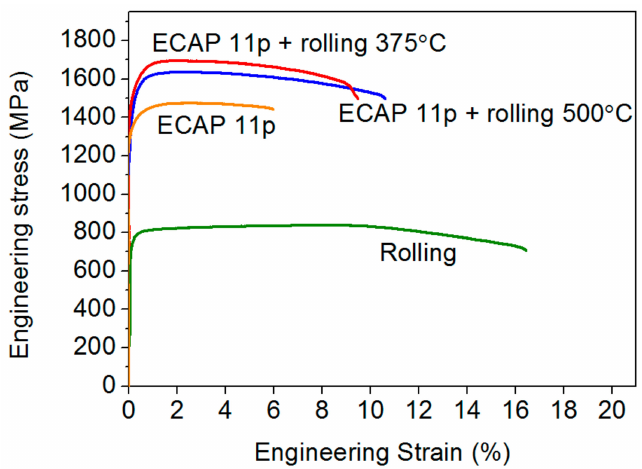
Figure 9. Engineering “stress–strain” curves for the TWIP steel processed by warm rolling, ECAP to 11 passes (denoted as ECAP 11p), and ECAP 11p + rolling at two temperatures. Note that the elongation to failure of the rolled and ECAP 11p + rolled samples cannot be directly compared to the elongation to failure of the ECAP 11p samples due to different designs of the tensile specimens. Table 2. Mechanical properties of the TWIP steel subjected to rolling and ECAP to 11 passes (denoted as ECAP 11p) + rolling. State σ 0.2 , MPa σ UTS , MPa Rolling at 375 ◦